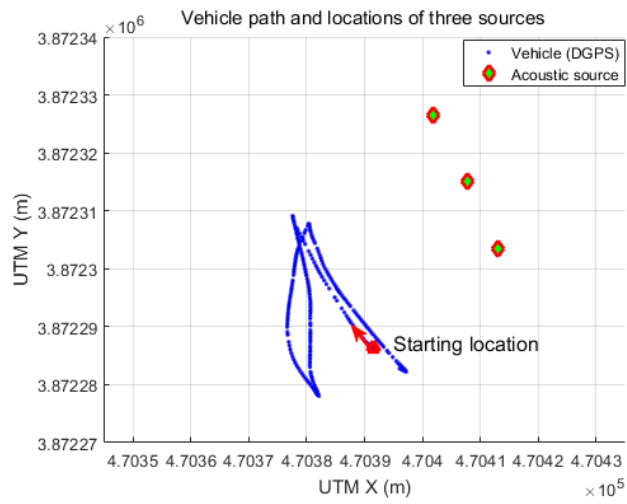
Figure 7. Vehicle path and locations of three acoustic sources acquired from DGPS.